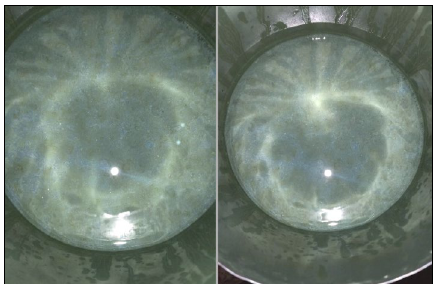
Figure 2. Samples PA1 and PA2 in the can with visible flocculation, unstabilized pigment in vehicle and blushing.